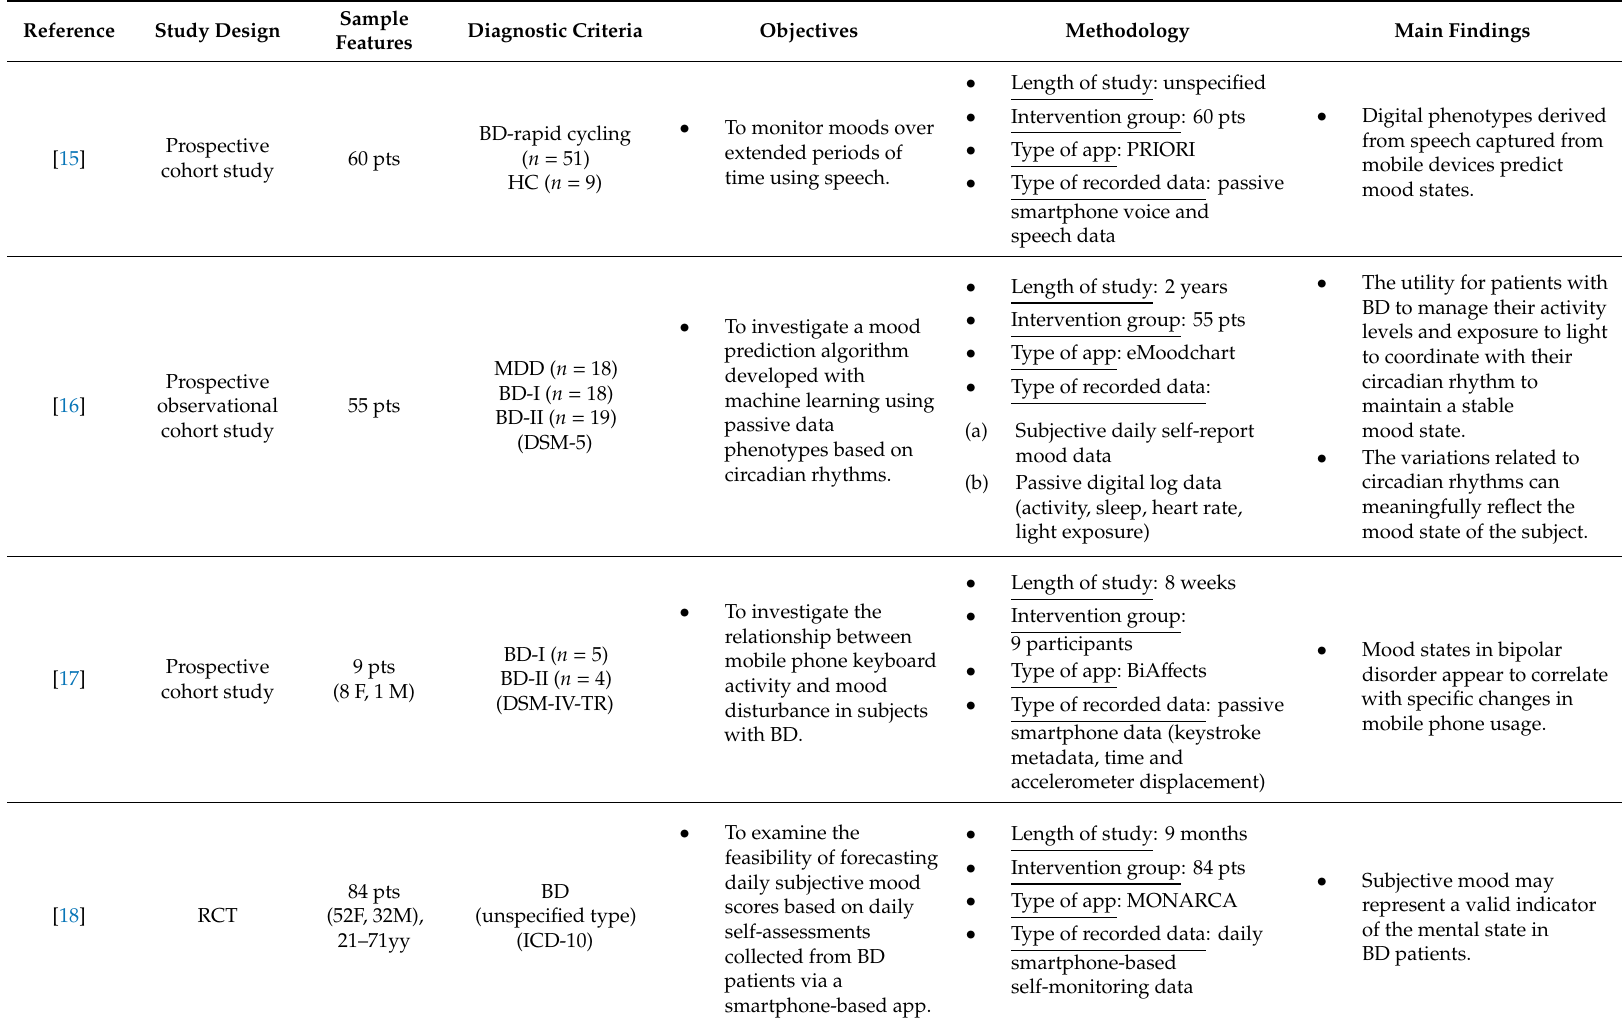
Table 1. Summary of